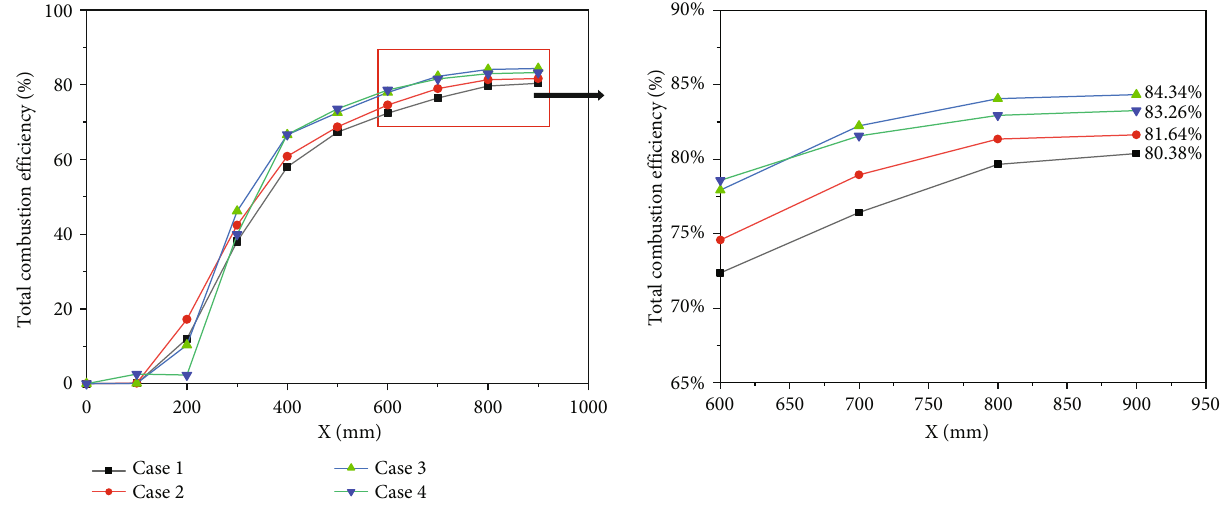
Figure 14: Total combustion e ffi ciency in each cross section of